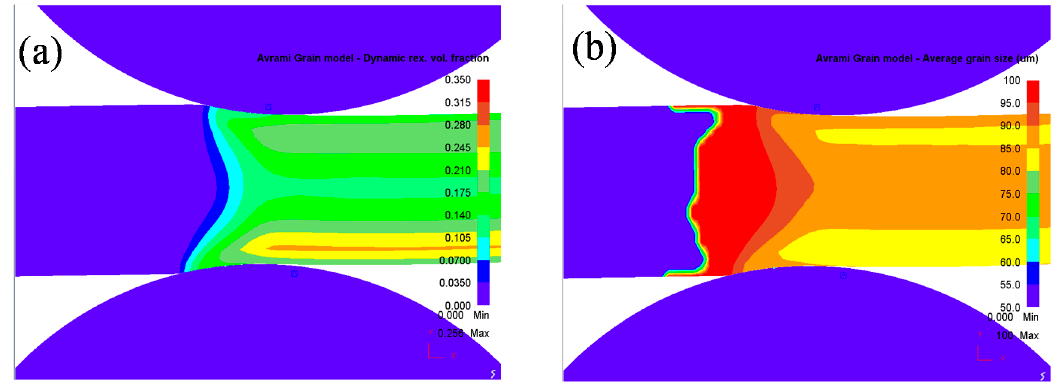
Figure 3. Distribution of ( a ) Dynamic recrystallization (DRX) fraction and ( b ) average grain size of plate during asymmetrical shear rolling.